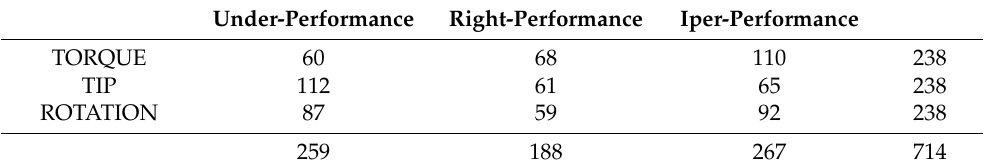
Table 4. Chi-square test. Under-Performance Right-Performance Iper-Performance TORQUE